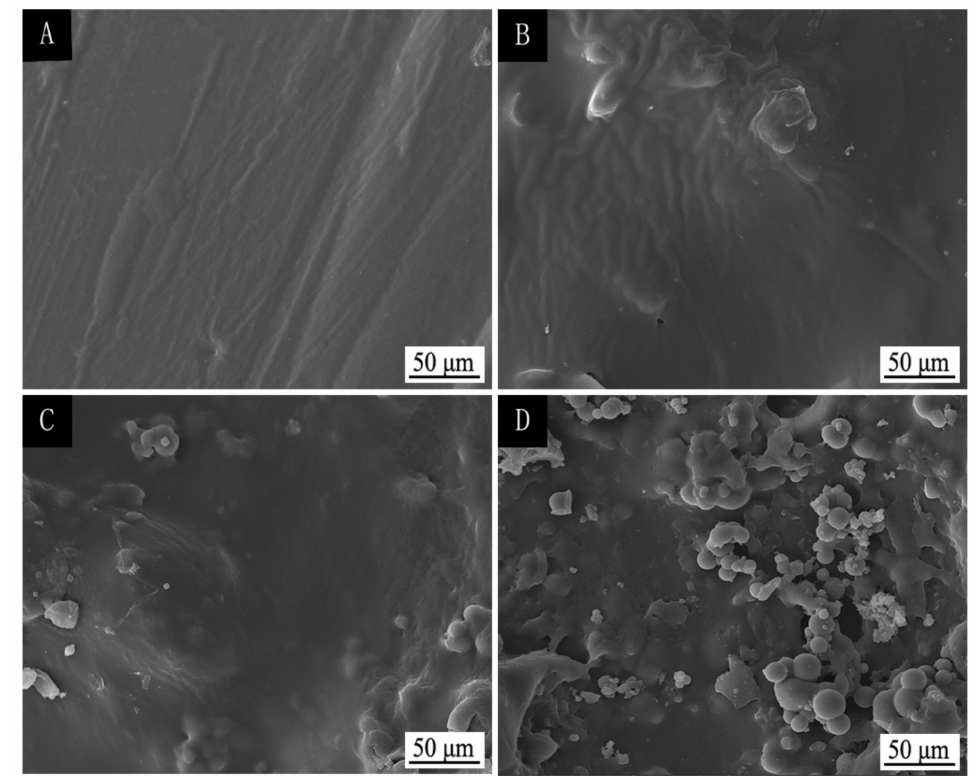
Figure 8. SEM of waterborne primer coating with different concentration of microcapsules (stirring rate 600 rpm): ( A ) 0; ( B ) 5.0%; ( C ) 10.0%; ( D ) 25.0%.